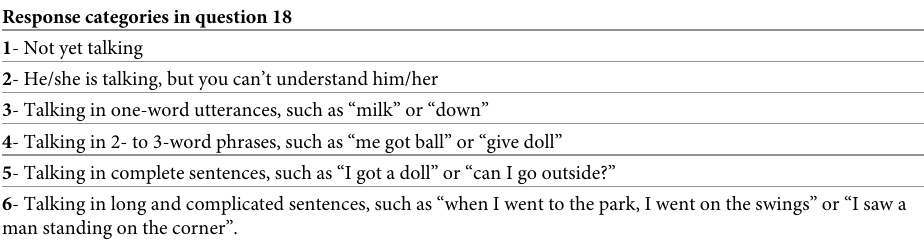
Table 1. In question 18 of the questionnaire at 3 years of age, mothers are asked which of the six response catego- ries best described the speech performance of their child.